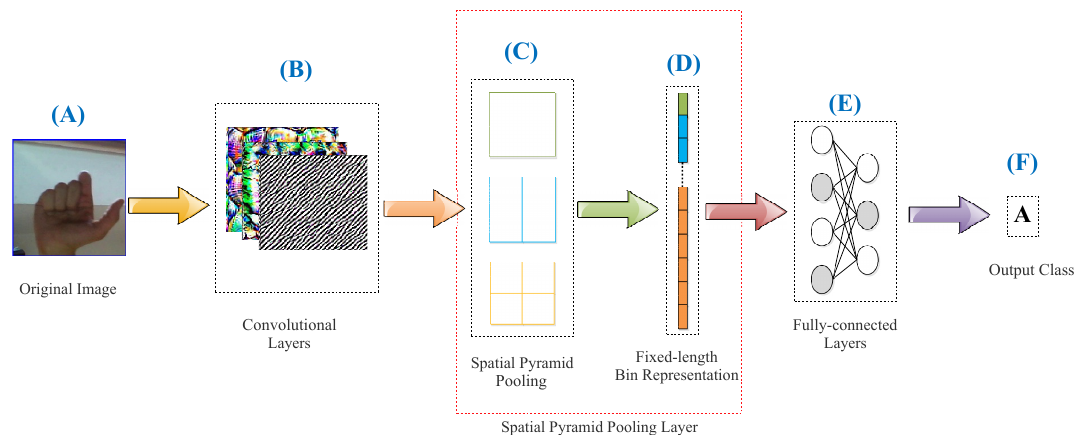
Figure 4. Spatial pyramid pooling in a DCNN. ( A ) A block diagram input is subjected to ( B ) convolutional feature pooling, then ( C ) max-pooled spatial pyramid pooling (SPP) with ( D ) a fixed number of bins; the result is finally transferred to ( E ) the fully connected (FC) layer, which ( F ) classifies the